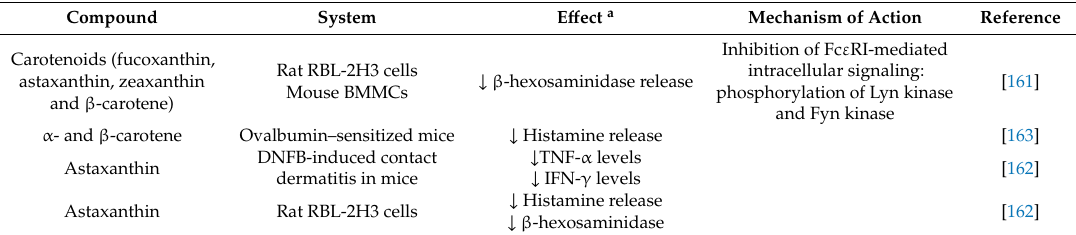
Table 6. Immunomodulatory e ff ects of carotenoids on mast cell